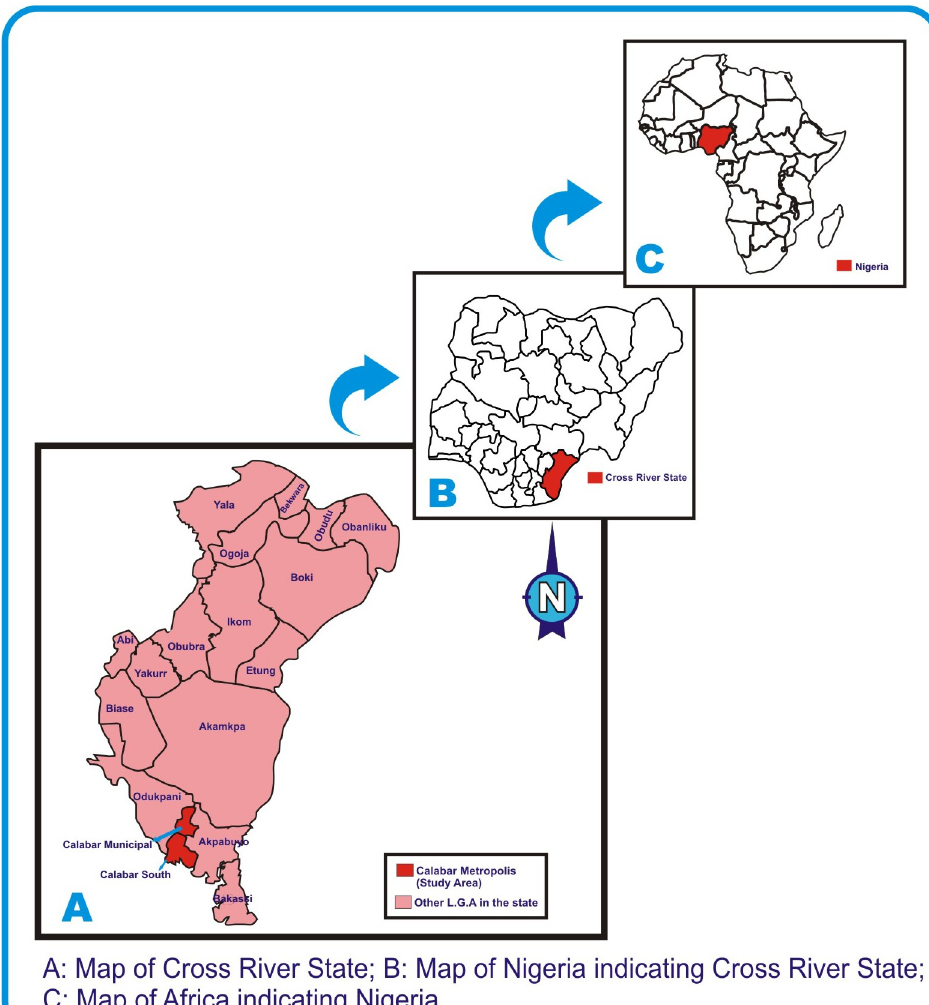
Fig 1. Map of the studied area.